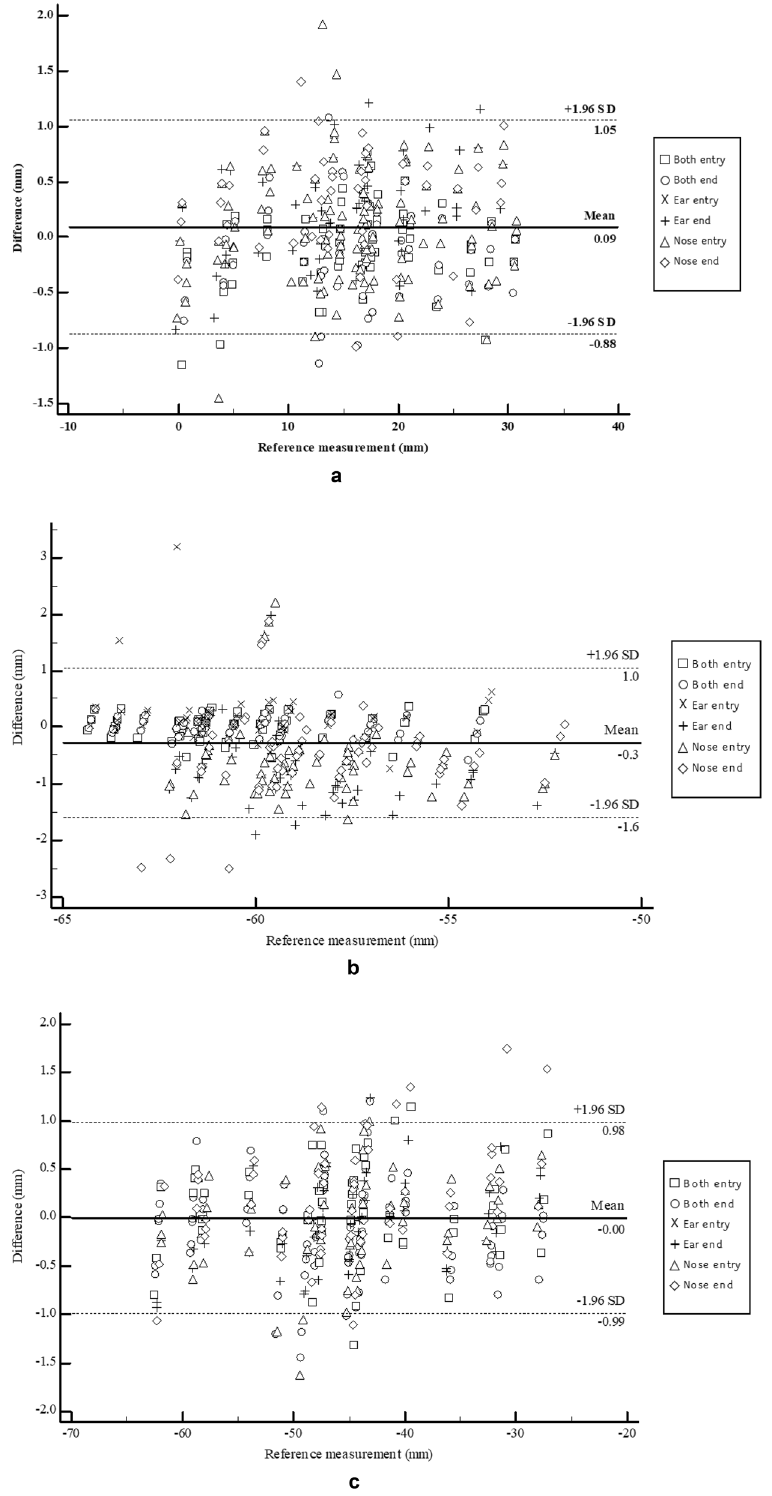
Figure 3. Bland–Altman plot evaluation of the accuracy of the entry point of the skin cancer guide using nose, ear, and both nose and ear as an attached area for X, Y, and Z axes. ( a ) Planned point vs actual point at X-axis. ( b ) planned point vs actual point at Y-axis. ( c ) planned point vs actual point at